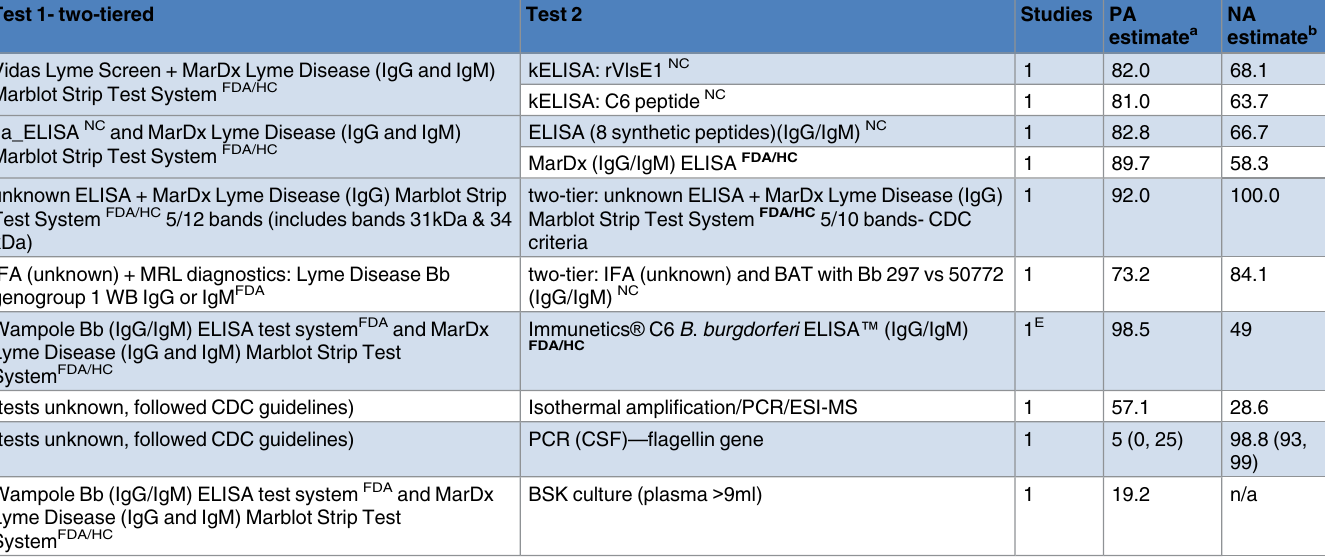
Table 5. Summaryof agreementbetween tests reported in eight studies (10 lines of data) that examined two-tier serology testing compared to a different test or two-tier protocol. Test 1- two-tiered Test